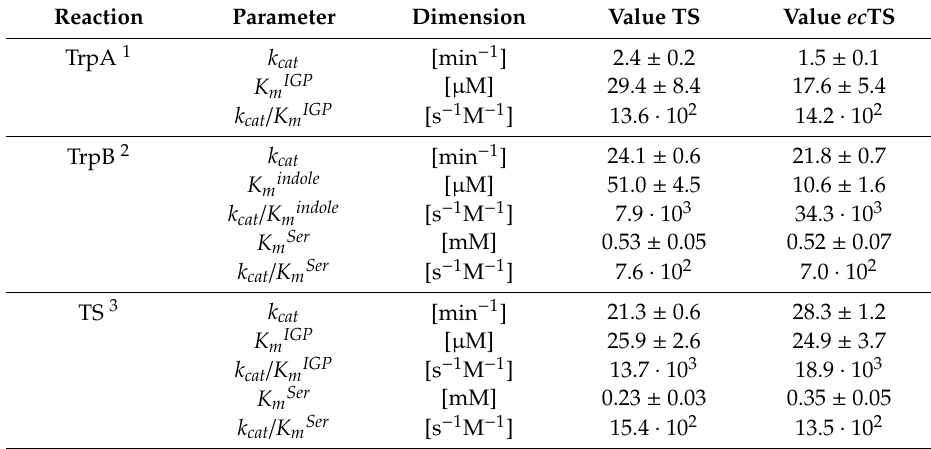
Table 1. Steady-state kinetics of TS and ec TS for the TrpA and TrpB partial reactions, and the overall TS